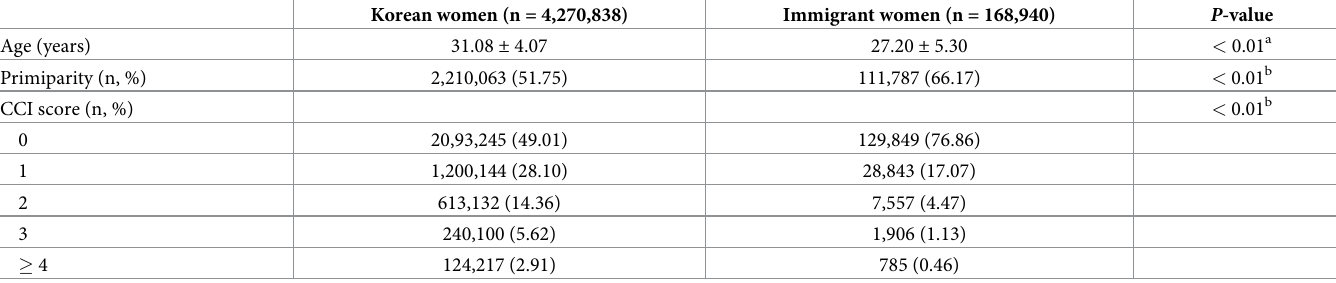
Table 1. Basic characteristics of the study